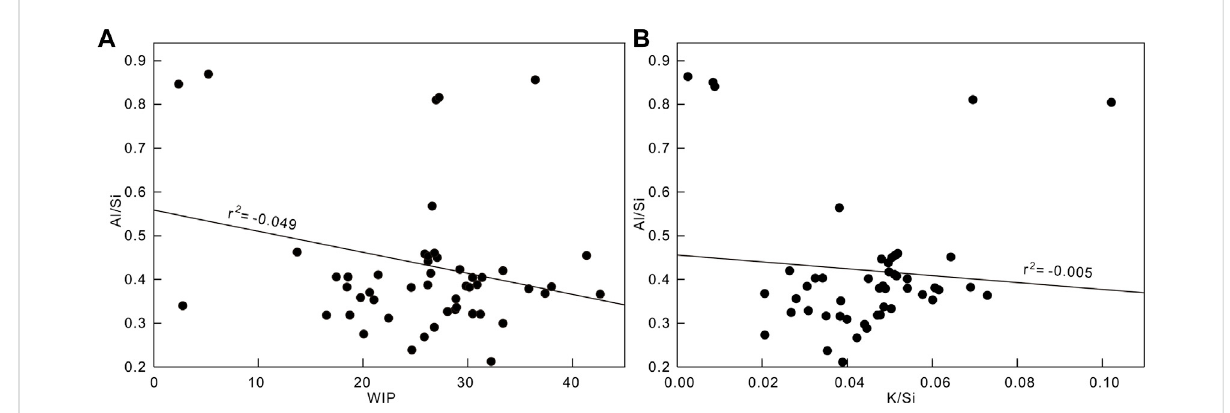
FIGURE 4 Plots of Al/Si ratio vs. weathering index of Parker (WIP) (A) and K/Si (B) showing no signi fi cant sedimentary sorting effect on sample